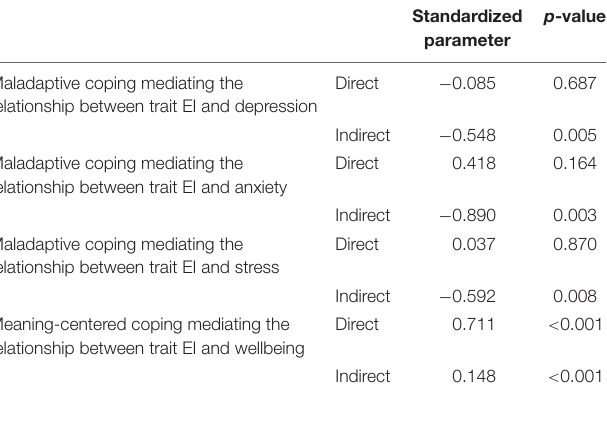
TABLE 4 | Direct and indirect effects from mediation testing.